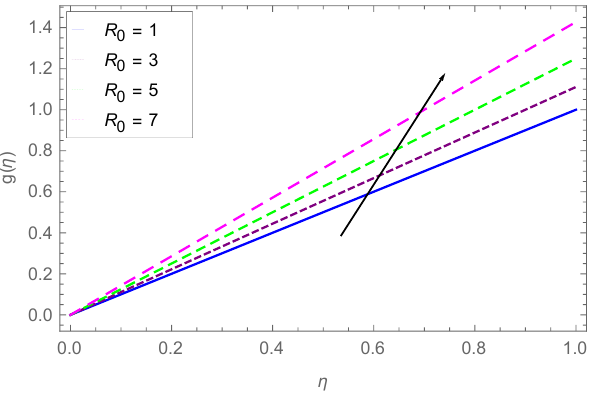
Figure 13. Graph displaying g ( η ) dependence on R 0